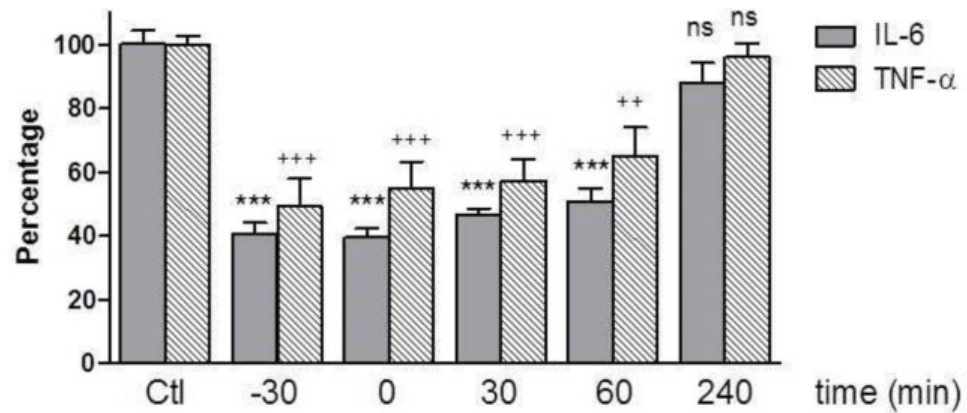
Fig. 5 Inhibitory effects of 250 nM of recombinant human ZPI (rhZPI) according to the delay within lipopolysaccharide (LPS) is added to the whole blood. rhZPI was added 30 min before, simultaneously or 30, 60 and 240 min after the addition of LPS (10 ng/mL). Results are expressed as percentages of IL-6 or TNF- α production in the absence of rhZPI (controls) which were considered arbitrarily as 100%. Results (mean (cid:4) 1 SEM) are theaverage of 3independent experimentsintriplicate. (cid:5)(cid:5)(cid:5) p < 0.001 ascompared tothe productionof IL-6in the presence of LPS alone. þþ < 0.01, þþþ < 0.001 as compared to the production of TNF- α in the presence of LPS alone (Dunnett ’ s multiple comparisons test following one-way ANOVA).